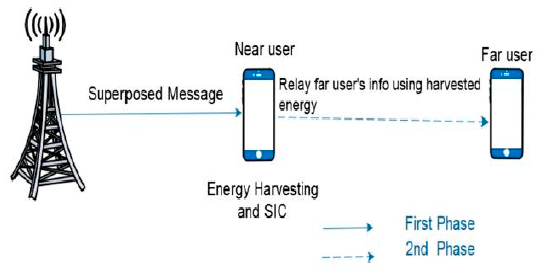
Figure 1. SWIPT with cooperative